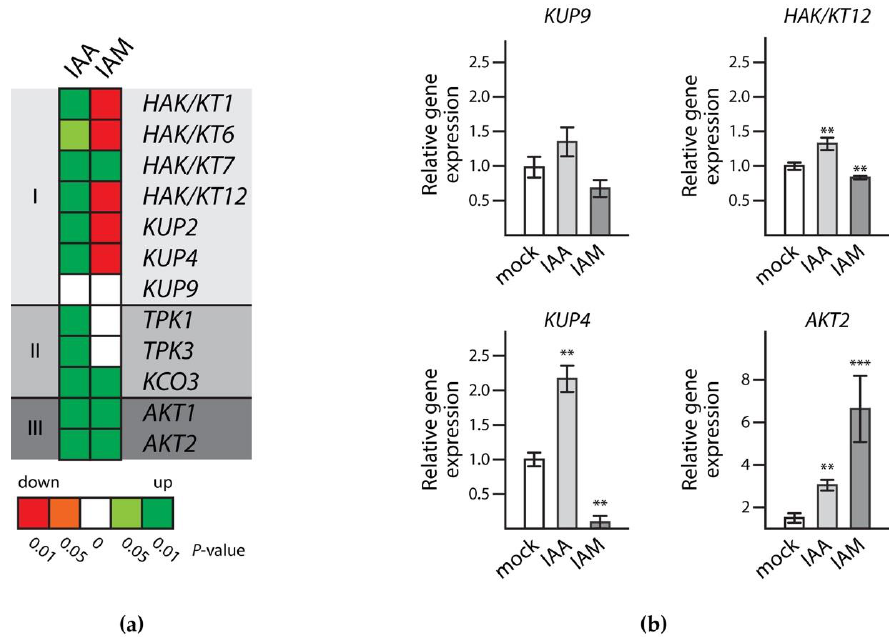
Figure 5. Transcriptional regulation of potassium transporter/channel genes by auxins. ( a ) Relative expression profiles of selected genes in siliques treated with either IAA or IAM. The genes are organized according to their family affiliations. I, KT/KUP/HAK-type transporters; II, tandem pore K + (TPK) channels; III, voltage-gated Shaker -like K + channels; ( b ) Exemplary qRT-PCR results for the transcriptional responses of HAK/KT12 , KUP4 , KUP9 , and AKT2 at 48 h after the treatment with either a mock solution (0.1% EtOH ( v / v )), or 100 µM IAA and IAM, respectively. Data represent relative expression values ± SE, n = 9 (Student’s t -test; ** p < 0.01, *** p < 0.001).